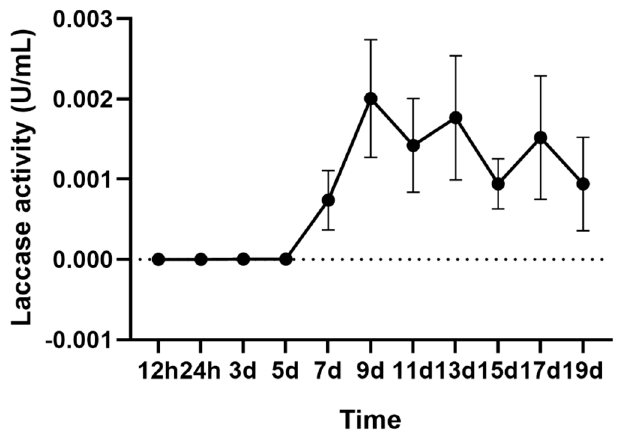
Figure 1. The laccase activity of A. areolatum from 1–19 days.